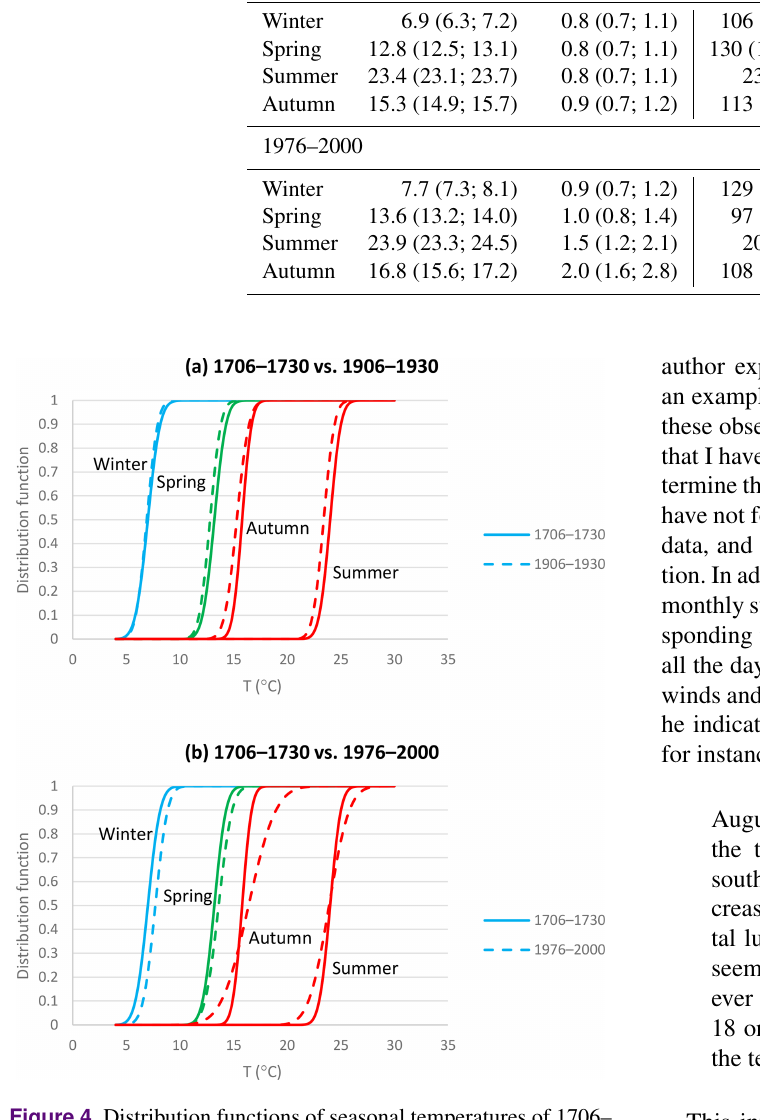
Figure 4. Distribution functions of seasonal temperatures of 1706– 1730 and comparison with 1906–1930 (a) and 1976–2000 (b)